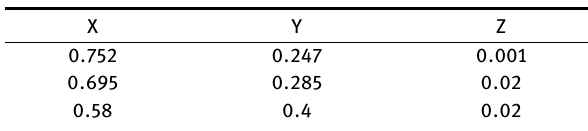
Table 1. Initial abundances by mass fraction of the stellar sequences computed in this work.